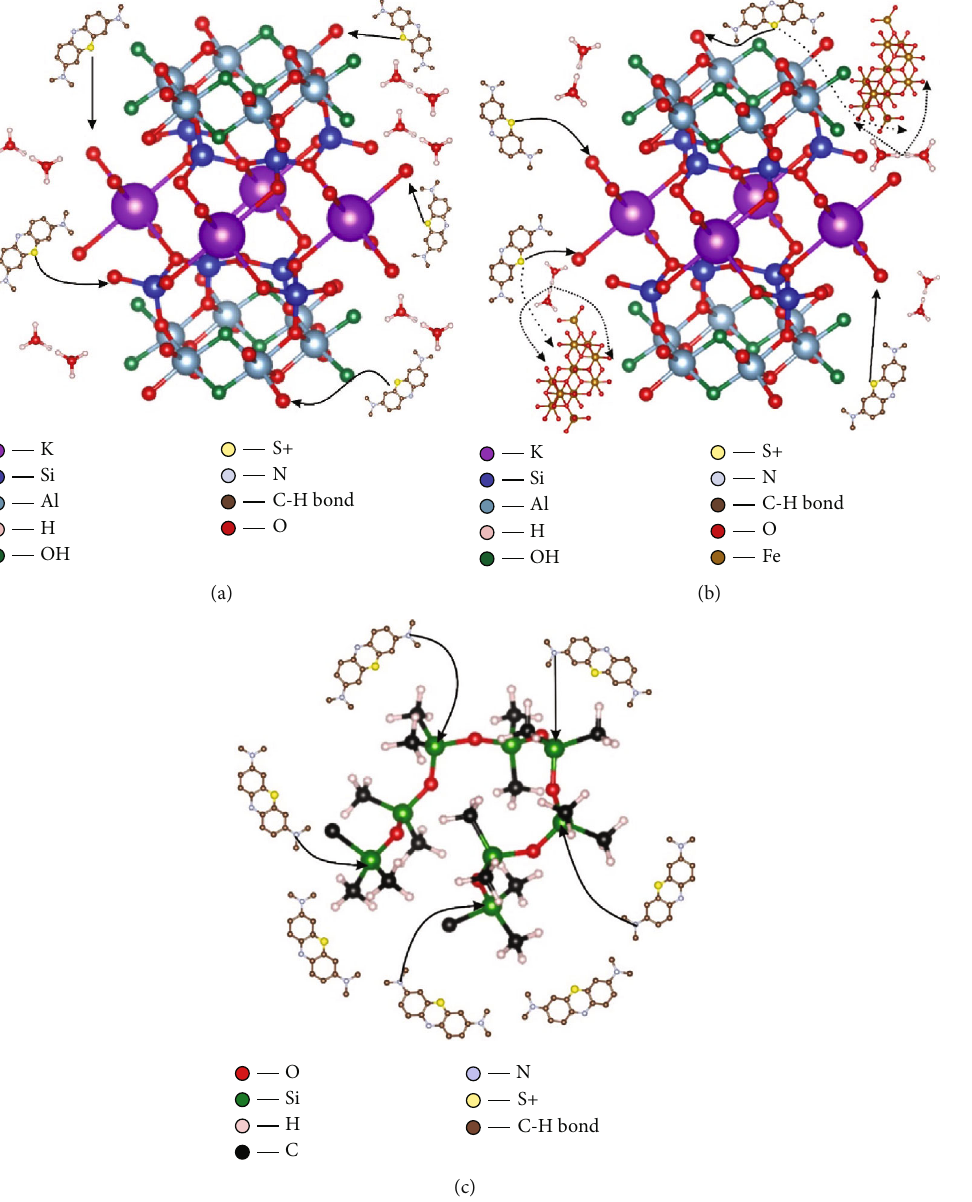
Figure 10: (a) Illustration of adsorption mechanism A. (b) Illustration of adsorption mechanism B. (c) Illustration of adsorption mechanism